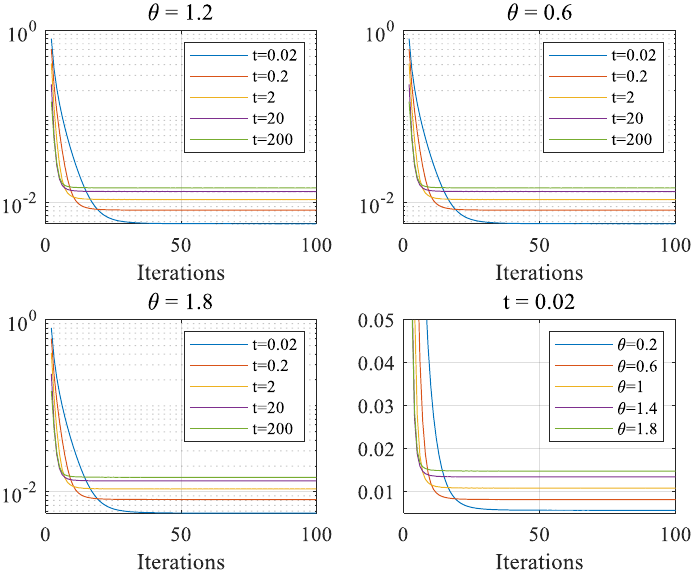
Figure 4. Convergence metrics of RMSEs of different values of θ , t .